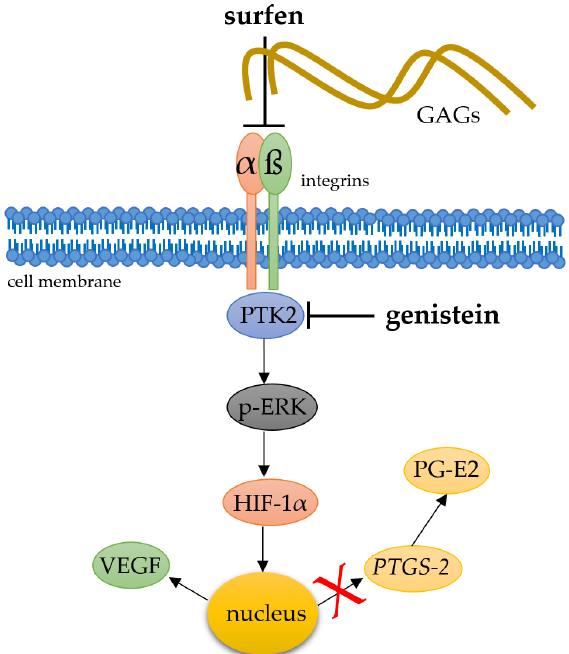
Figure 6. Simplified schematic presentation of a possible role of heparane sulfate integrin interaction and downstream phosphorylation of kinases for the mechanotransductive stabilisation of HIF-1 α . To address this question, glycosaminoglycan antagonist surfen and PTK-2 inhibitor genistein were applied. αβ : integrins, PTK2: protein tyrosine kinase 2, p-ERK: phosphorylated extracellular signal- regulated kinases.